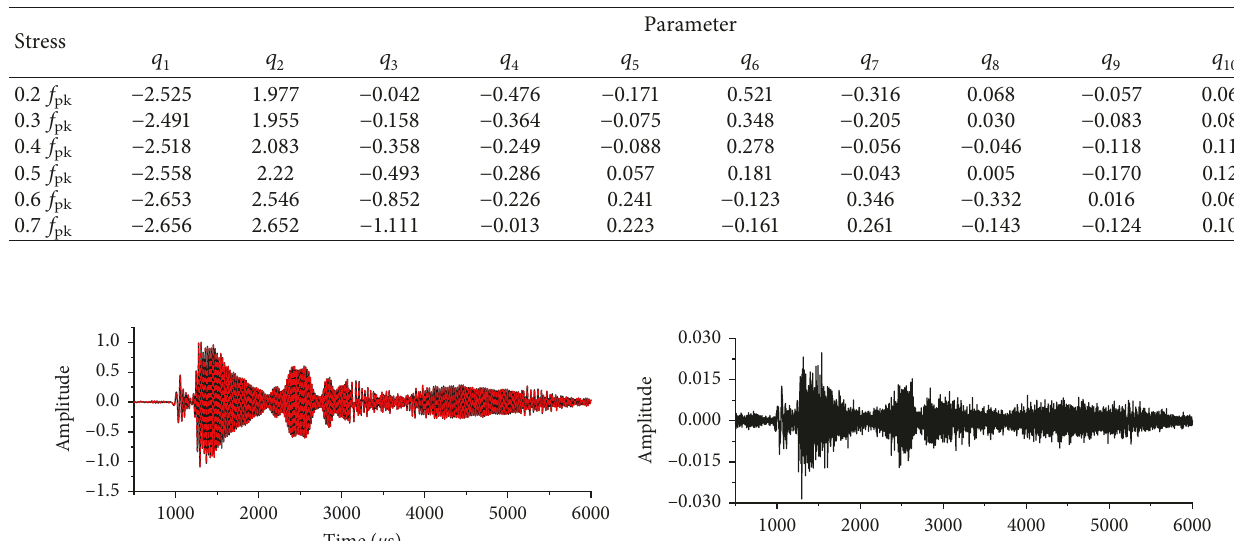
Table 2: Identification model parameters in different tension force.